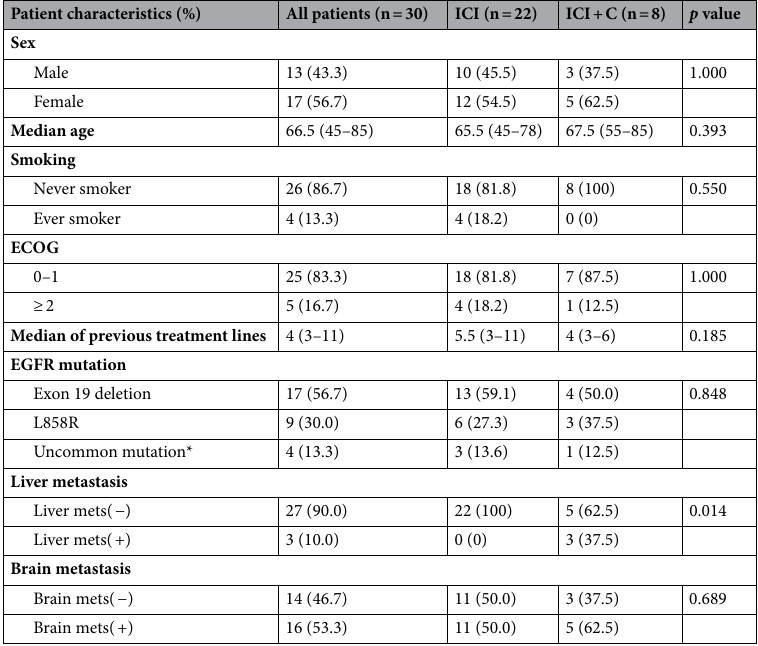
Table 1. Patients with EGFR mutations (n = 30). *One exon 20 insertion, two G719X, one L861Q.